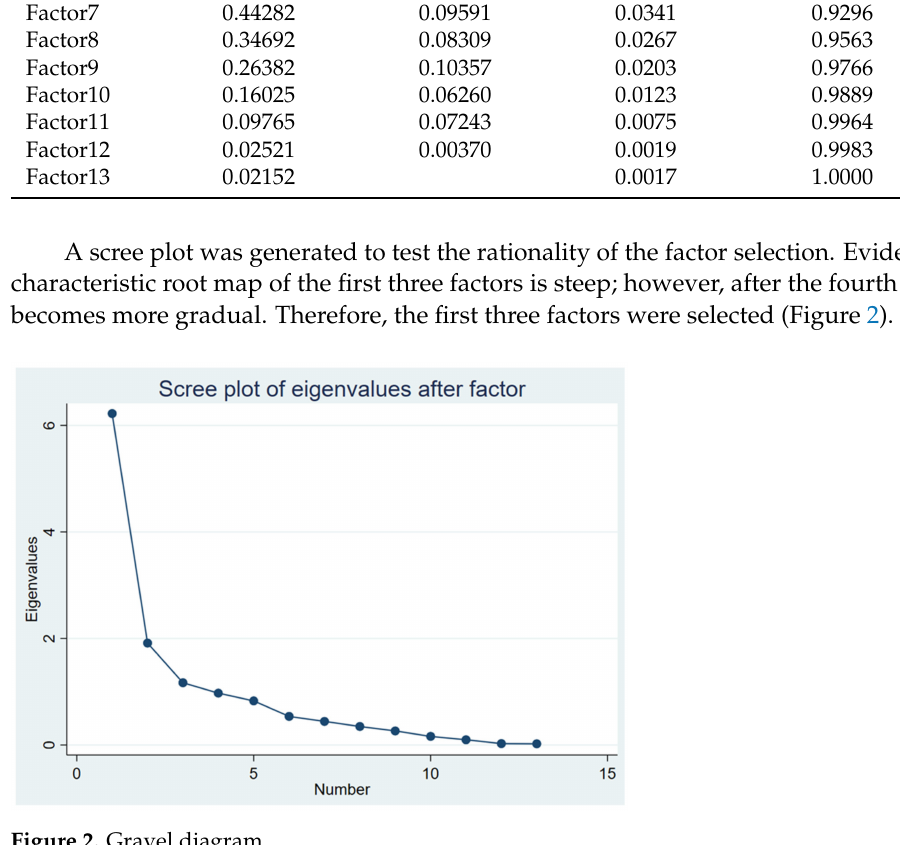
Figure 2. Gravel